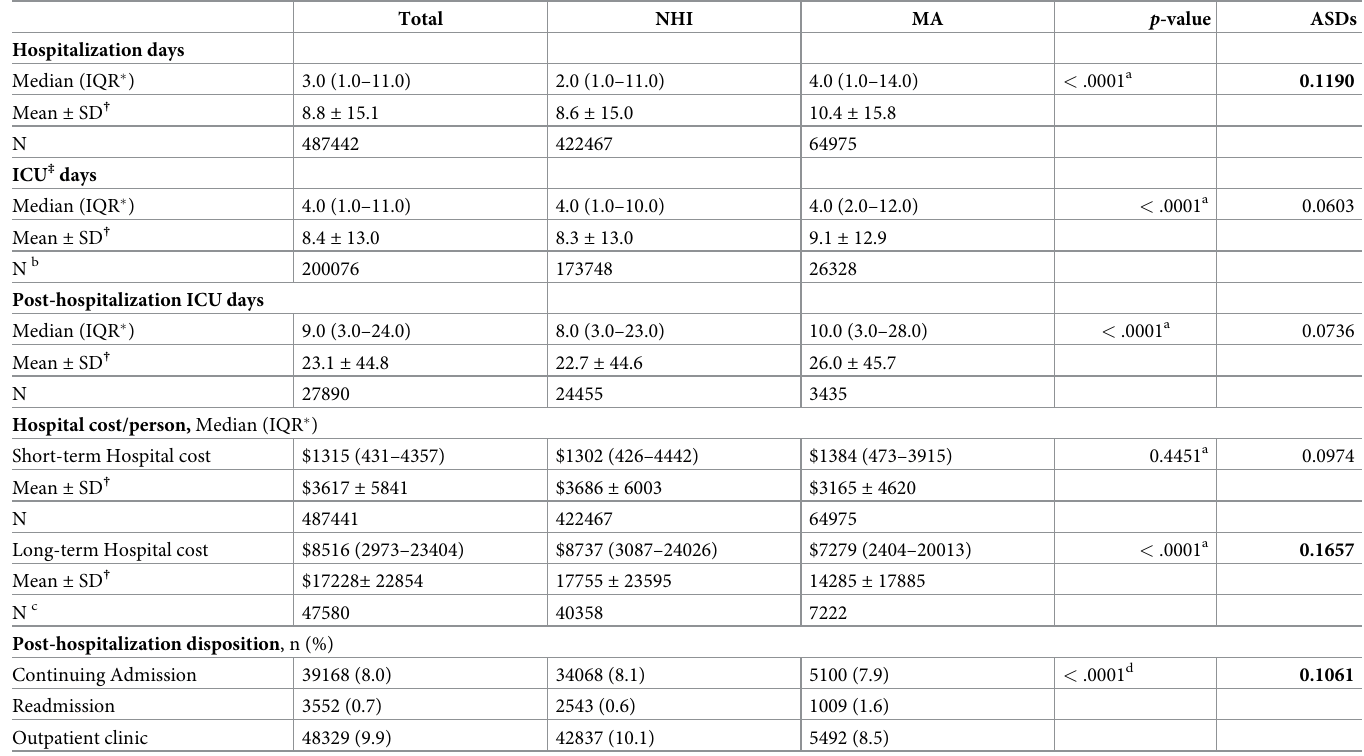
Table 5. Length of stay, hospital costs, and post-hospitalization disposition in national health insurance group and medical aid